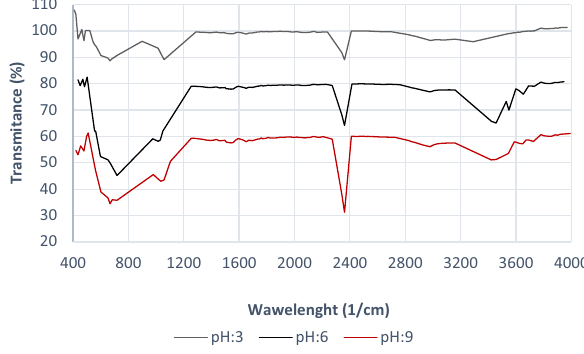
Fig. 8 The effect of initial pH on produced sludge in EC